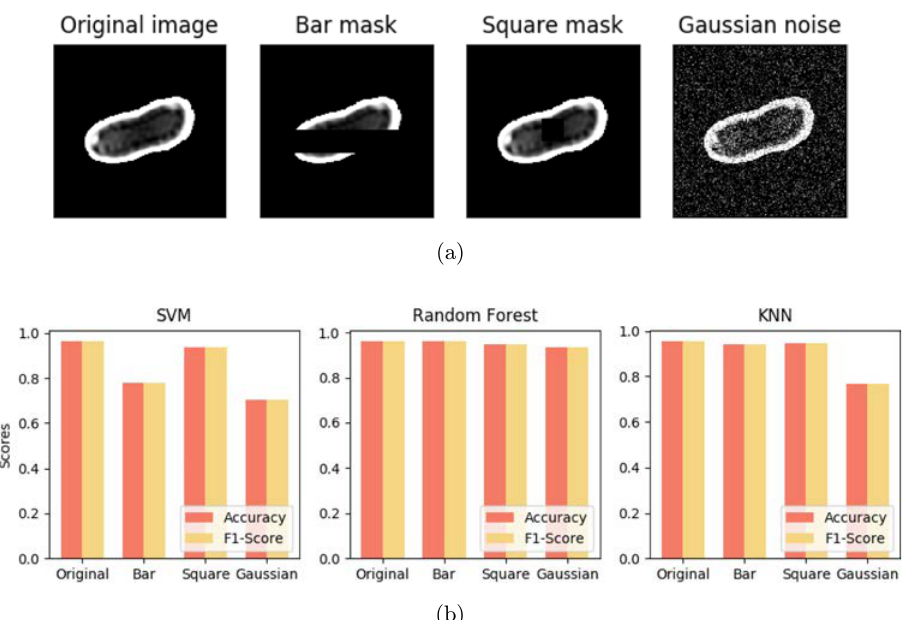
Fig. 7. (Color online) The robustness of di®erent classi¯ers under three kinds of noises. (a) Original images and the images with di®erent noises. (b) The testing results.